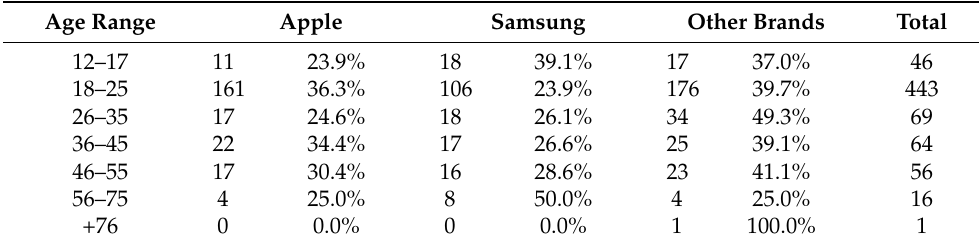
Table 3. Ownership of Smartphones from Apple, Samsung, and others, according to the age range of the